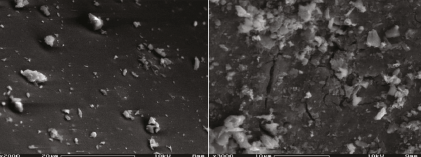
Figure 11: Microphotographs of an untreated coke particle (a) and a coke particle subjected to microwave treatment (b) [16].